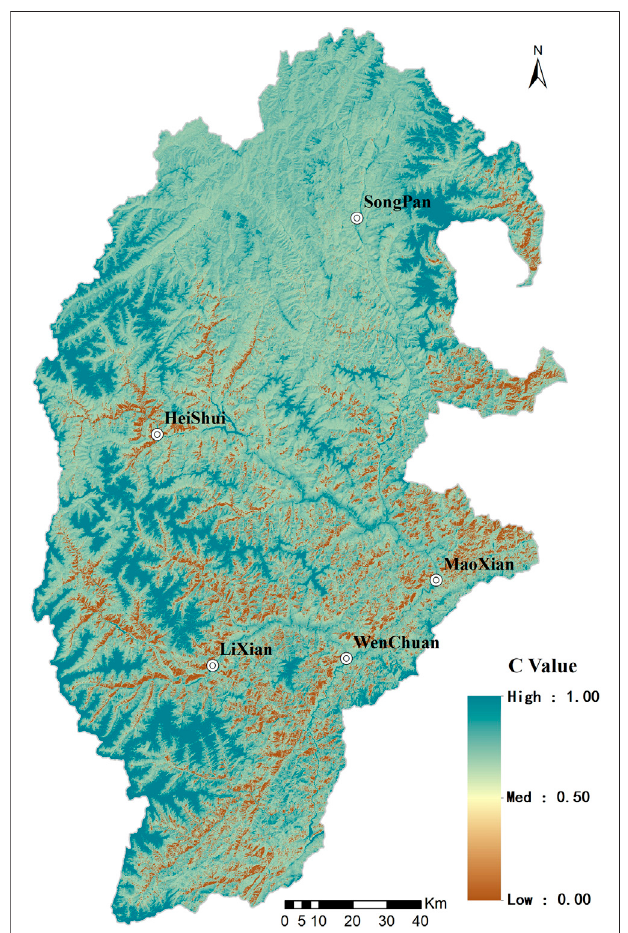
FIGURE 6 | C value of the upper reaches of Minjiang